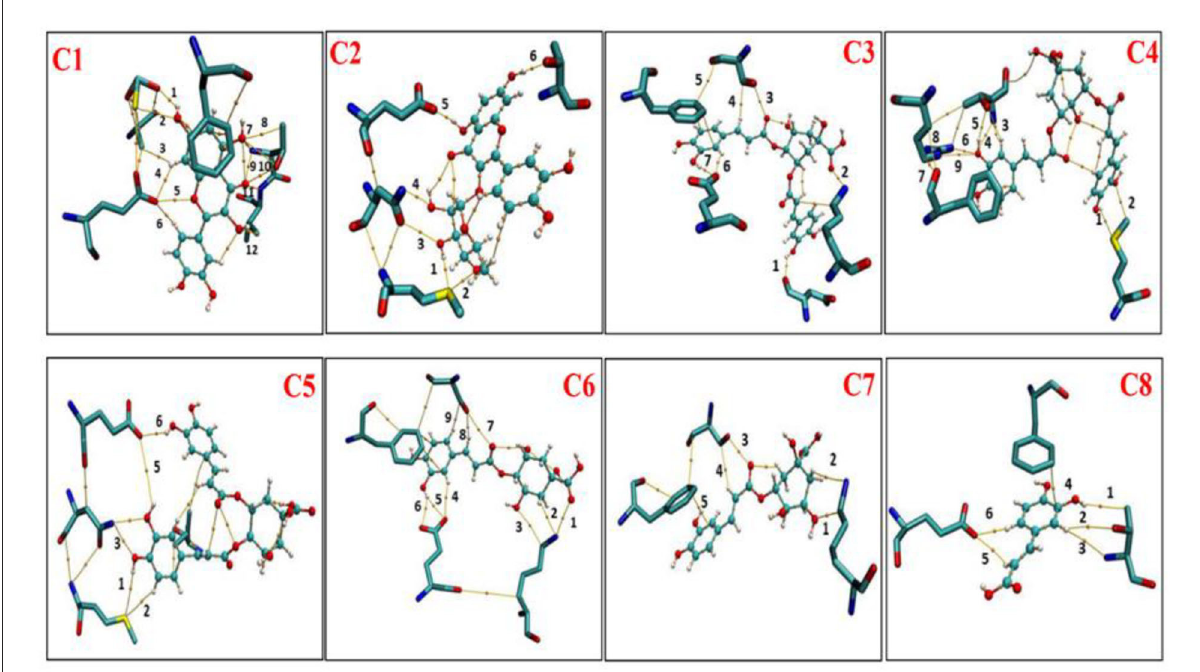
FIGURE11 Atom in molecules (AIM) analysis of phenolic compounds (C1-C8) with active residues of XO (Xanthine oxidase). C1, quercetin; C2, quercetin-3-rhamnoside; C3, 4,5-O-dicaffeoylquinic acid; C4, 3,5-O-dicaffeoylquinic acid; C5, 3,4-O-di-caffeoylquinic acid; C6, 4-O-caffeoylquinic acid; C7, 3-O-caffeoylquinic acid; and C8, caffeic